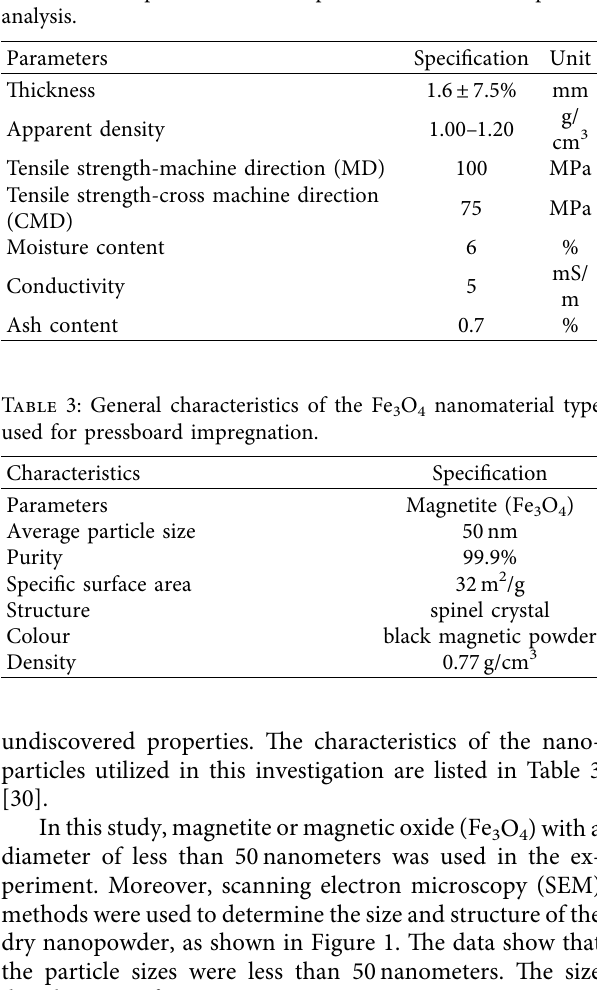
Table 2: Basic parameters of the pressboard used in the present analysis.